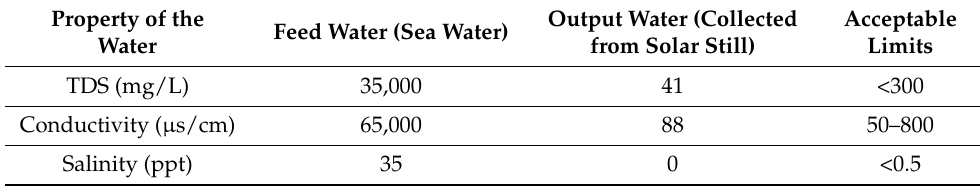
Figure 9. Variation of water and vapor temperatures in the presence of external reflectors for ( a ) depth of 4 cm ( b ) depth of 5 cm. Table 4. Concerning the qualities of input and output